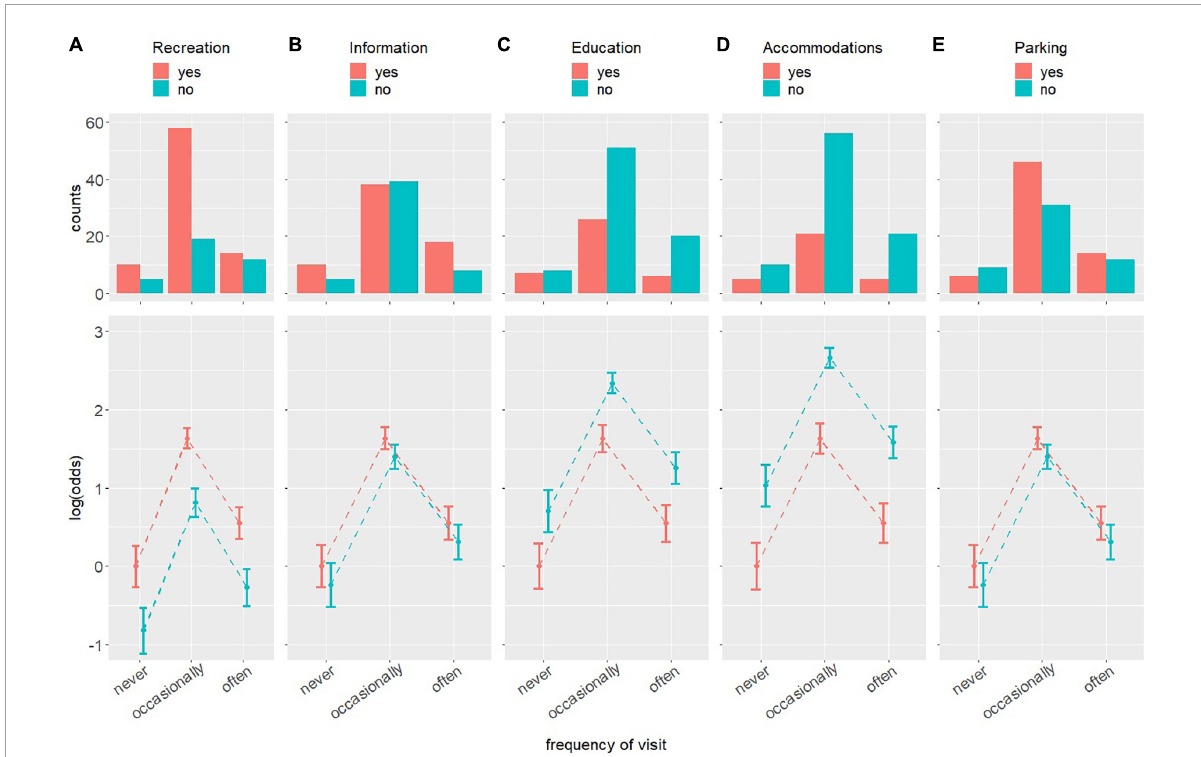
FIGURE3 Histograms and the logarithm of the odds resulting from applying a log-linear model in the cross-frequency tables of the relationships between the need of, from left to the right, recreation (A) , information (B) , education (C) , accommodations (D) , and parking (E) as amenities for PwNDs to visit and enjoy natural sites and PwNDs’ visit frequency to these